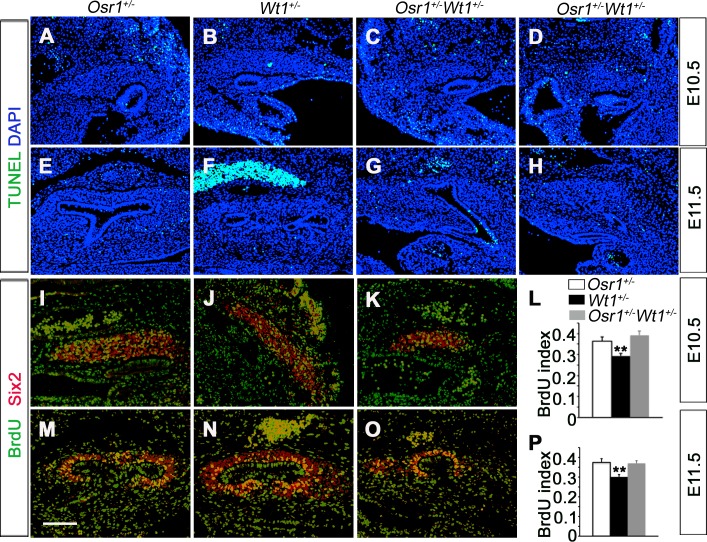
Analysis of cell apoptosis and proliferation during early kidney development in Osr1+/-Wt1+/- embryos and littermates.(A-H) Cell apoptosis is analyzed by TUNEL (green) and counterstained with DAPI (blue). TUNEL assay detected no obvious change in cell apoptosis in Osr1+/-Wt1+/- metanephric mesenchyme (C, D, G, H) compared with Osr1+/- (A, E) and Wt1+/- (B, F) metanephric mesenchyme at E10.5 (A-D) and E11.5 (E-H). (I-P) Analysis of cell proliferation by BrdU incorporation at E10.5 (I-L) (n = 18) and E11.5 (n = 7) (M-P) embryos. BrdU index is calculated by the ratio of BrdU-positive cells (green) versus Six2-positive cells (red). Scale bar, 100 μm.